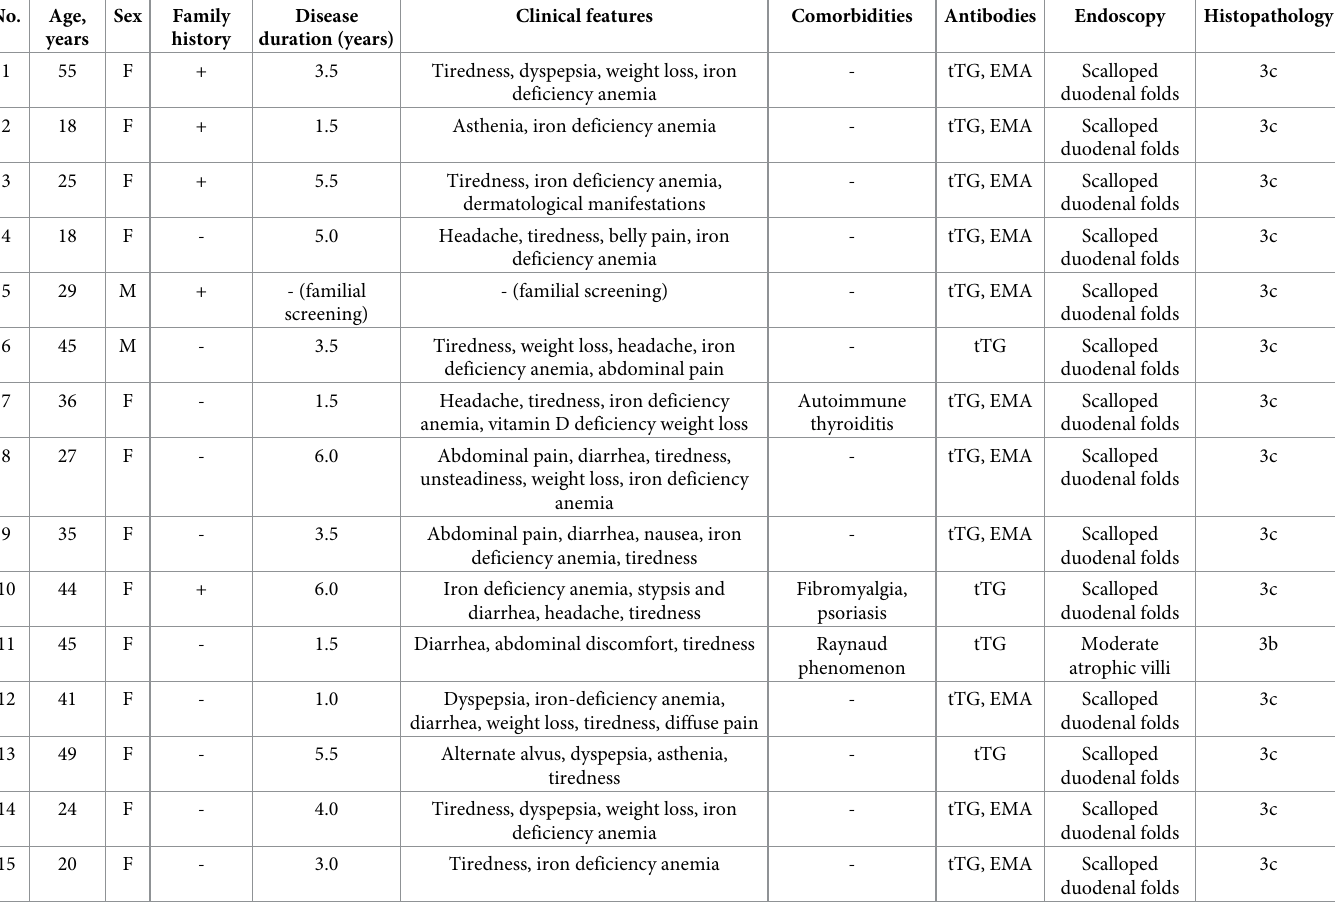
EMA = endomysial antibodies; F = female; M = male; tTG = tissue transglutaminase antibodies; Classification of histopathology according to the Marsh–Oberhuber grading system: 3a = mild villous flattening; 3b = severe villous flattening; 3c = complete villous flattening; + = positive/present; − =